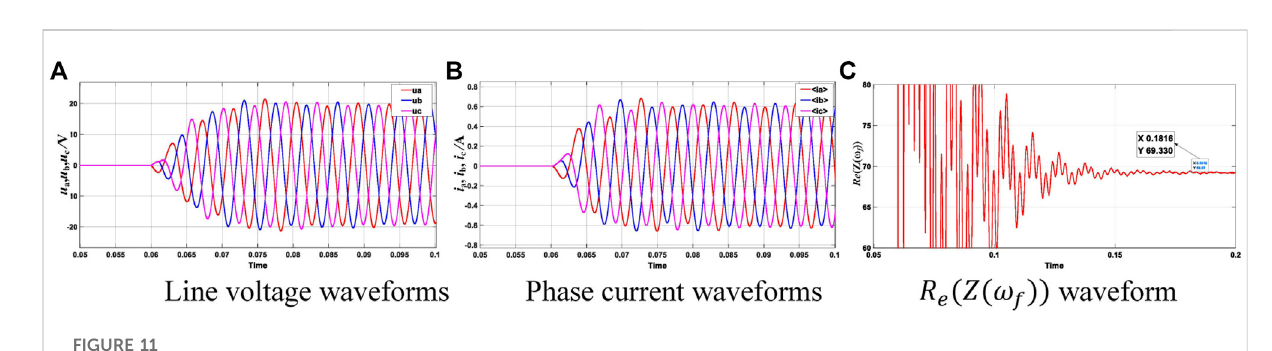
Two-phase fault or three-phase fault 1.139 1.693